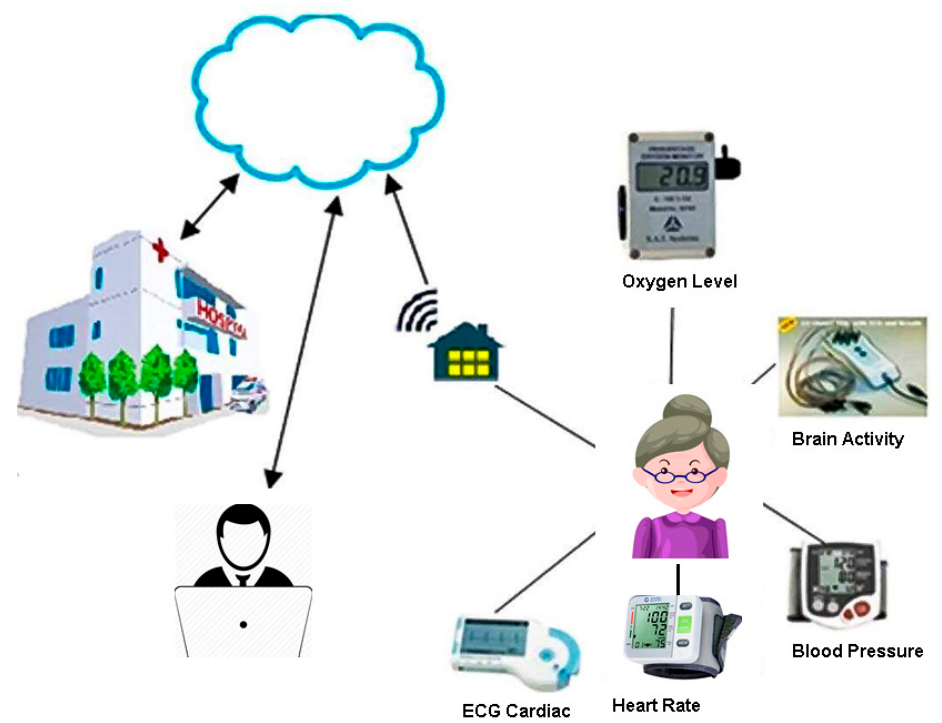
Figure 1. Motivation Scenario of Assisted Living in Internet of Things